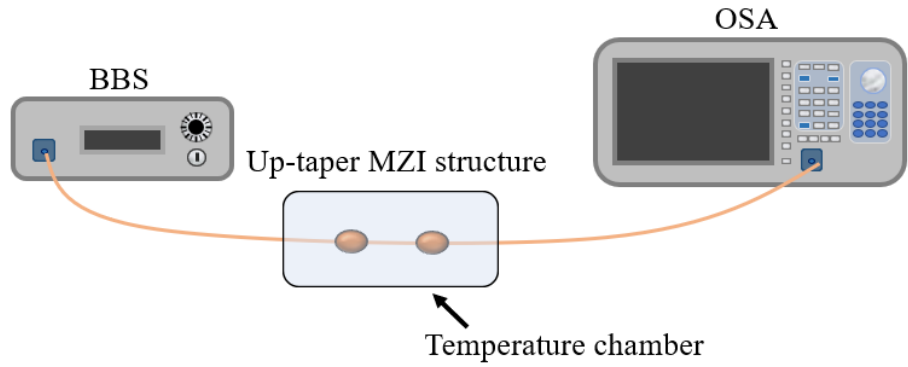
Figure 3. Experimental setup of Yb doped fiber up-tapered structure.